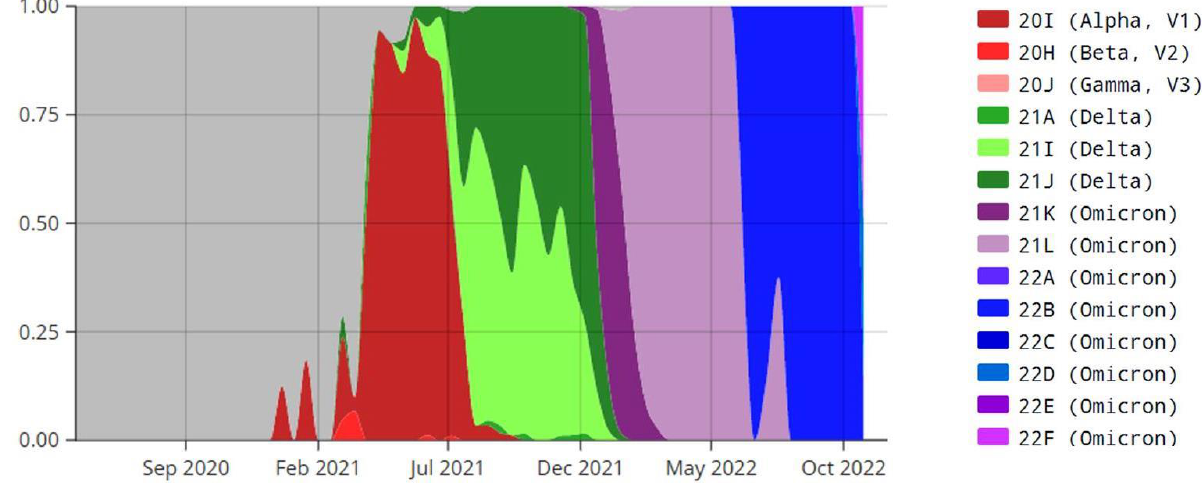
Figure 3. Proportions of the total number of sequences of the various variants of SARS-CoV-2 over time in Sri Lanka. X-axis: month and year, Y-axis: proportion of various variants of SARS-CoV-2. Panel on the right side of this figure shows the color codes of the various variants of SARS-CoV-2. This figure was adopted from Emma B. Hodcroft. 2021. “CoVariants: SARS-CoV-2 Mutations and Variants of Interest.” https://covariants.org/, accessed on 28 January 2023. Created with CC BY4.0.